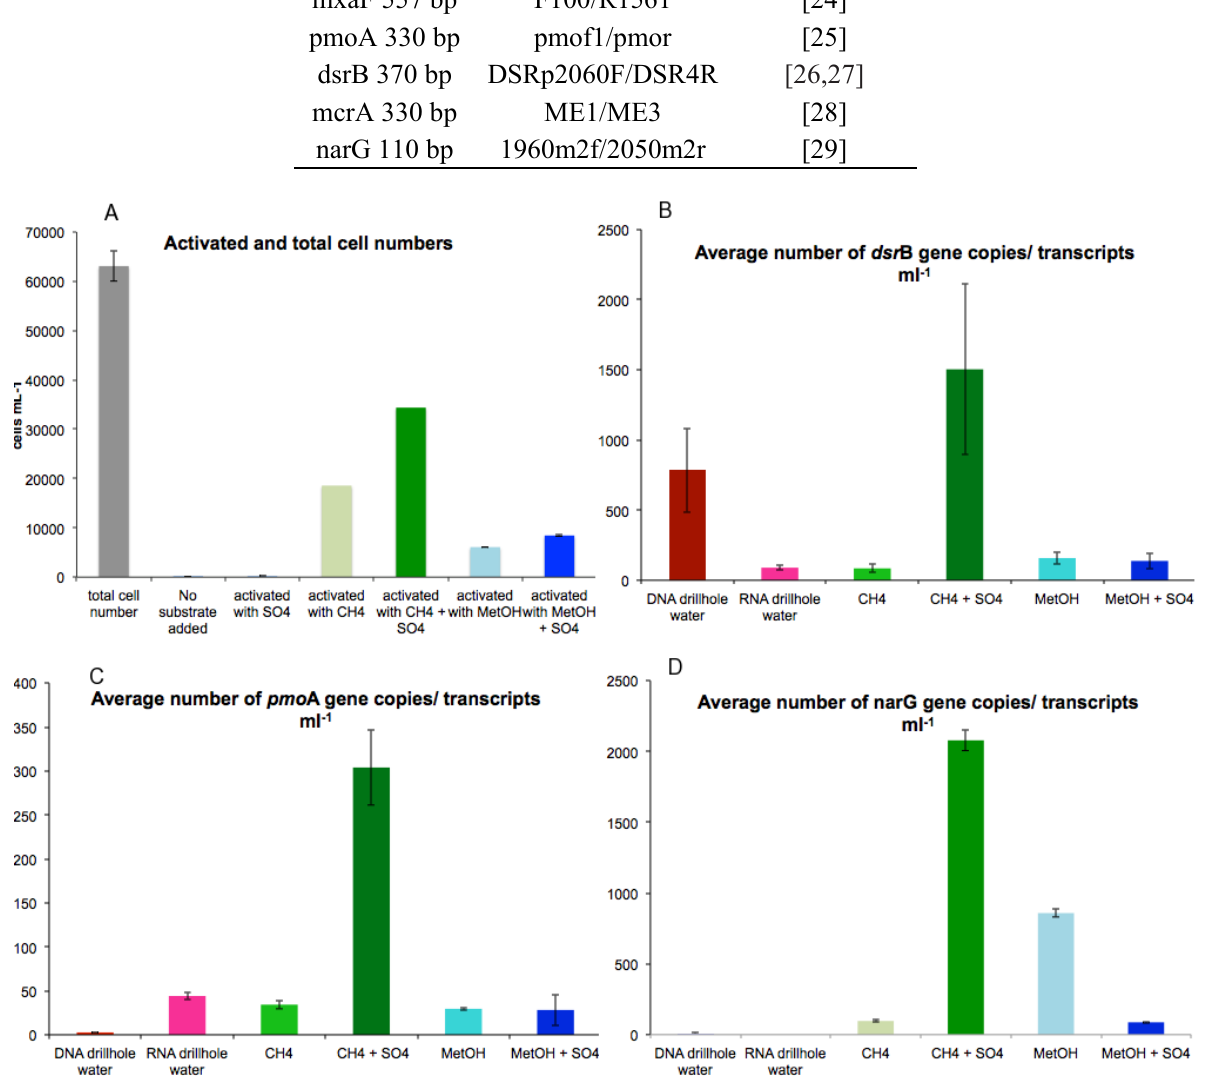
Figure 2. ( A ) Mean concentrations of microbial cells detected with DAPI and substrate-induced cells detected by Live/Dead staining, and ( B – D ) gene copies and transcripts mL −1 fracture fluid. Error bars represent standard error of mean ( n =